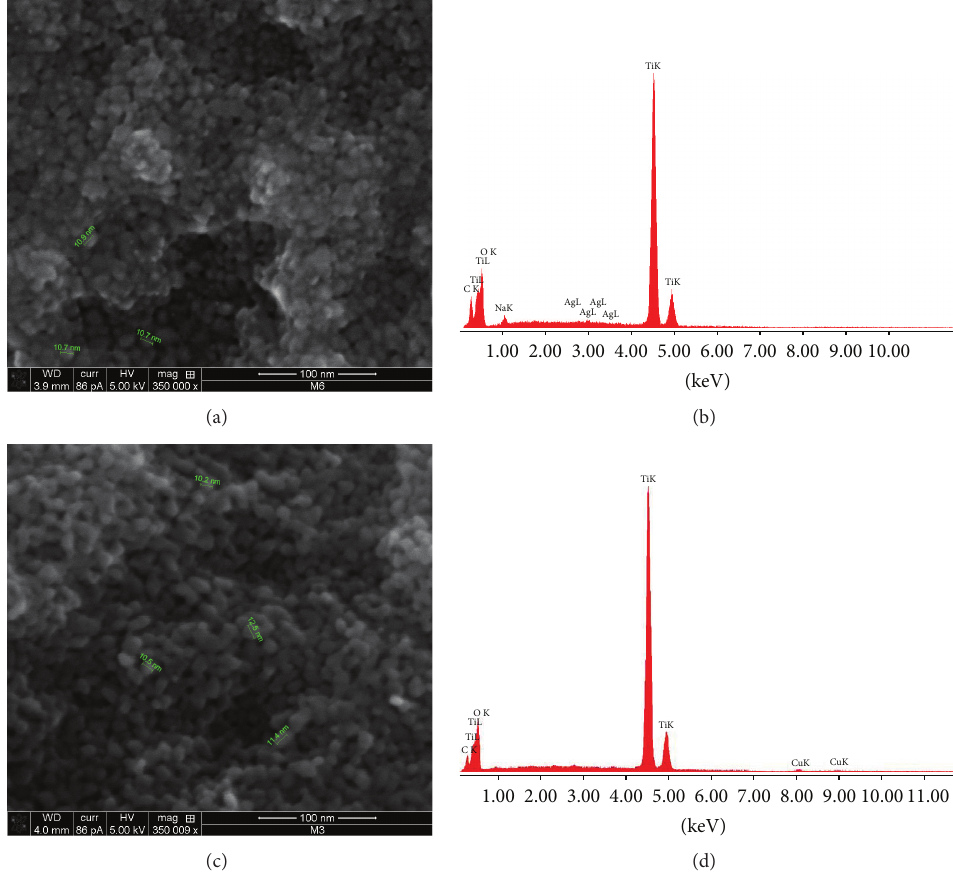
Figure 1: Characterization of NSMs. (a) SEM image of Ag@TiO 2 . (b) Elemental composition of Ag@TiO 2 (EDX). (c) SEM image of TiO 2 - Cu 2+ . (d) Elemental composition of TiO 2 -Cu 2+